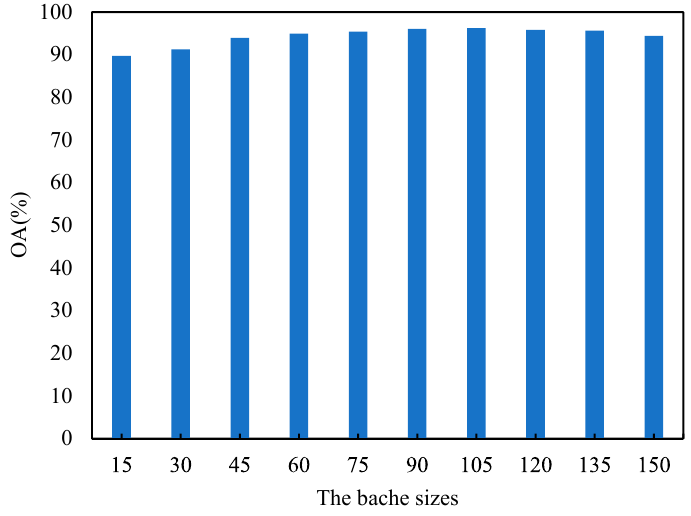
Figure 11. The classification accuracy varies with batch size.